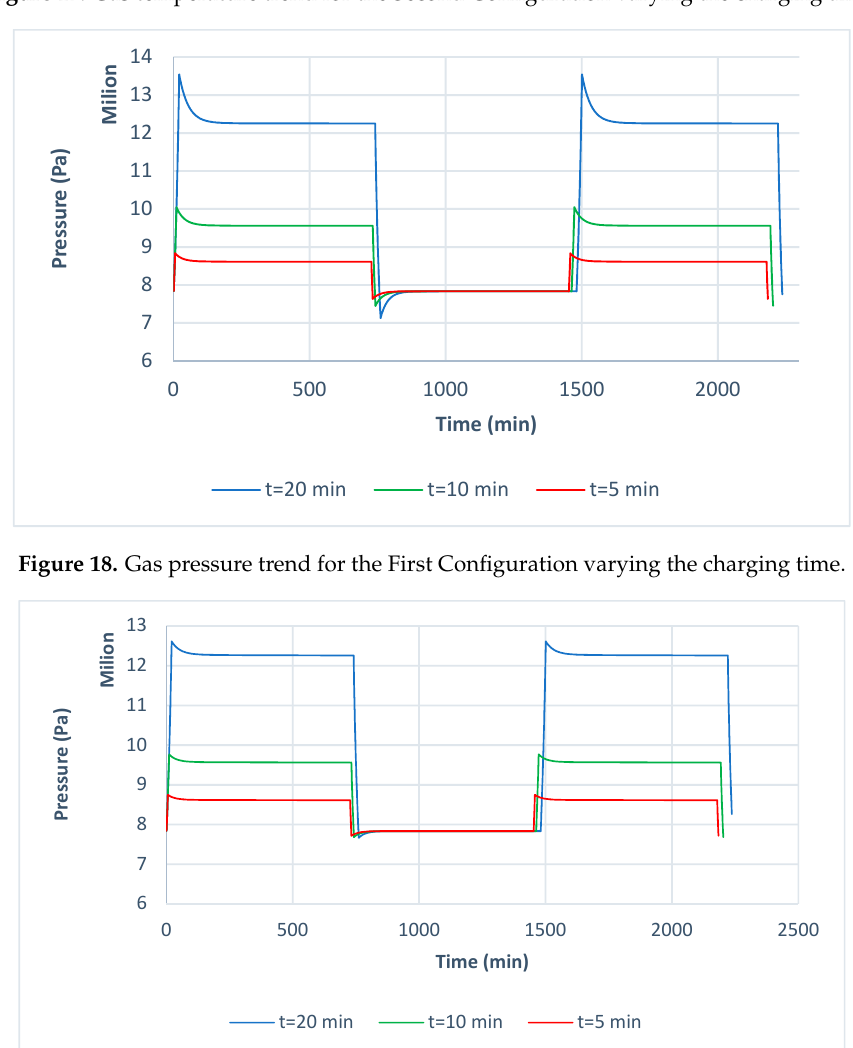
Figure 19. Gas pressure trend for the Second Configuration varying the charging time .